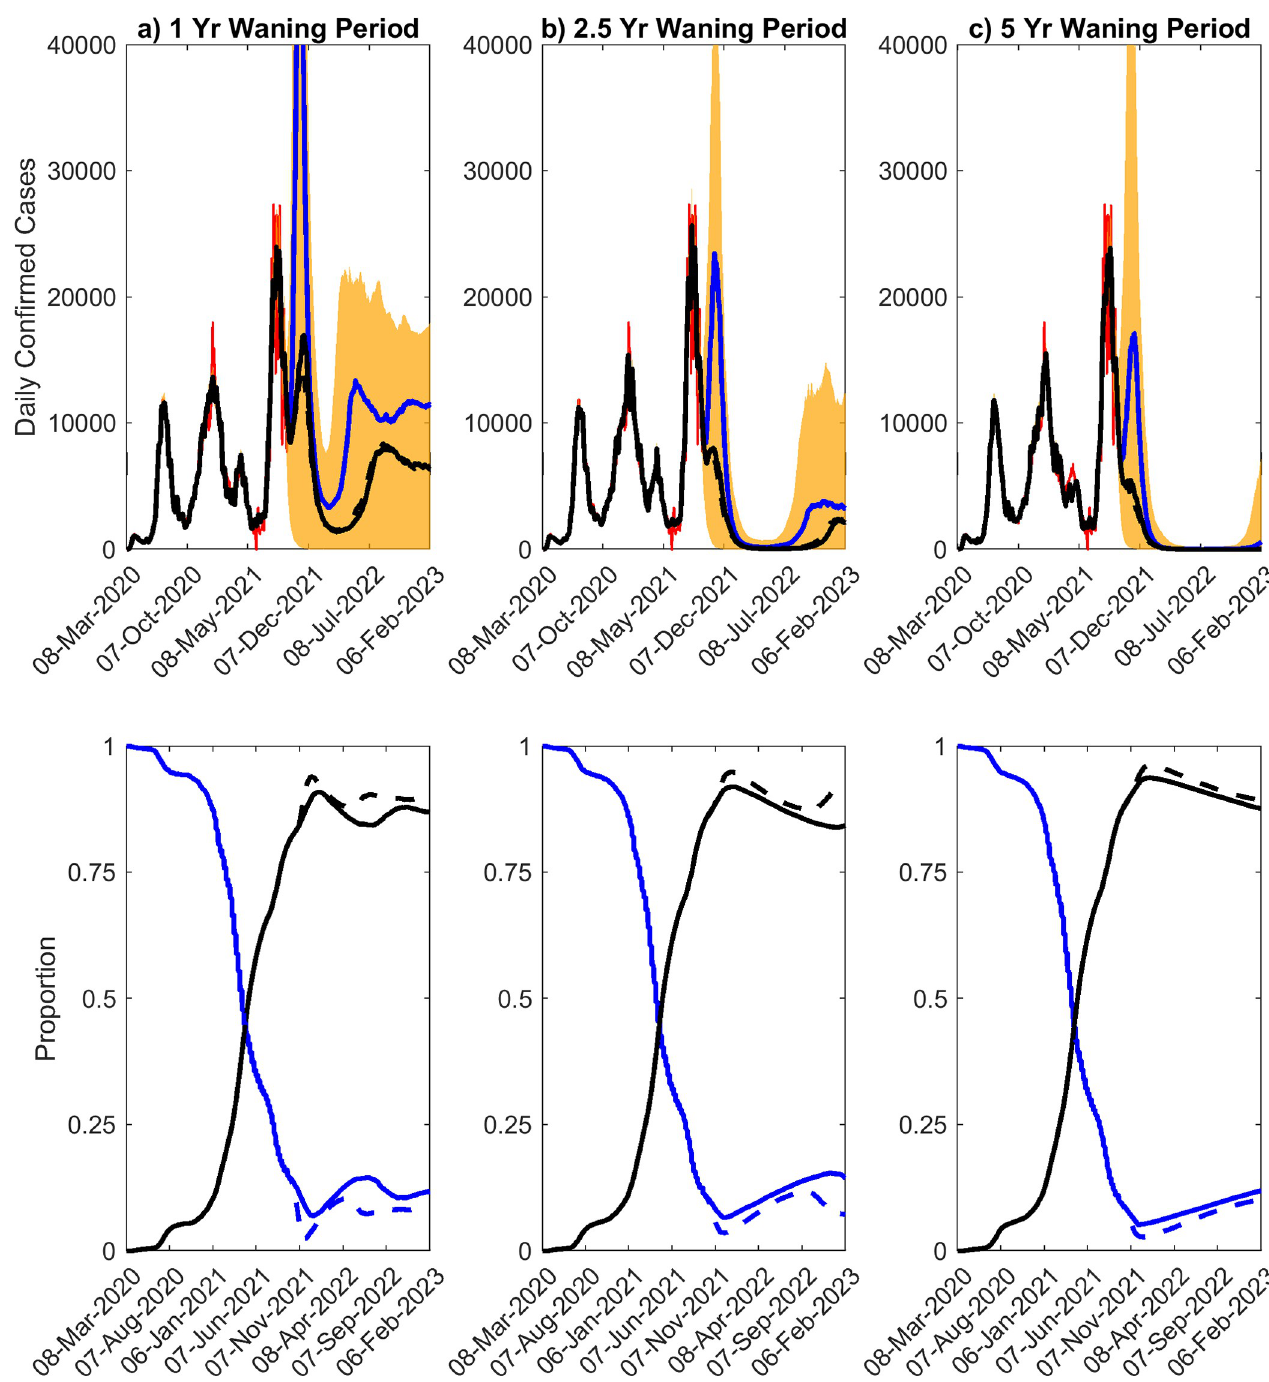
Fig 4. Scenarios of waning immunity. (Top row) Scenarios of waning immunity, given waning intervals of 1 year, 2.5 years, and 5 years. The median model predictions of confirmed cases given estimated social distancing measures as of Sept. 24 th 2021 and release of social measures are given by the black and blue curves, respectively. The 90% confidence interval for the median case is given by the orange shading, while the confirmed case data is given in red. (Bottom row) Forecasts for total proportion susceptible (blue), and total immune (black) are shown over time. Solid curves represent the impact of maintaining social measures and vaccination rates as of Sept. 24 th 2021, while the dashed curve denotes the effects for a full release of social measures.